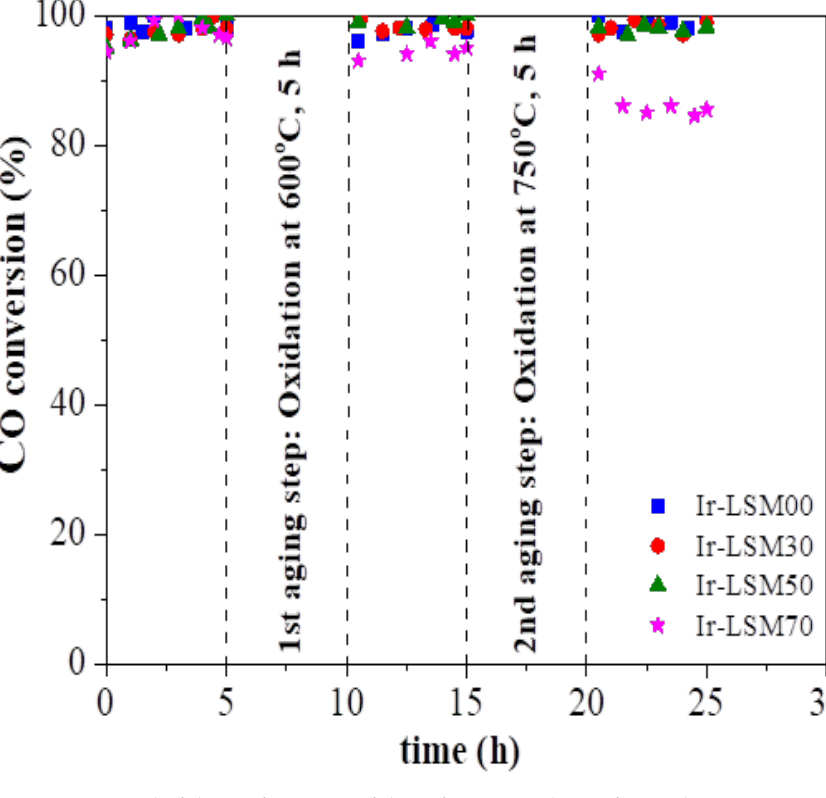
Figure 7. Control of the performance of the Ir/LSMx catalysts after each aging step, at 350 °C. Other experimental conditions are the same as in Figure 3.